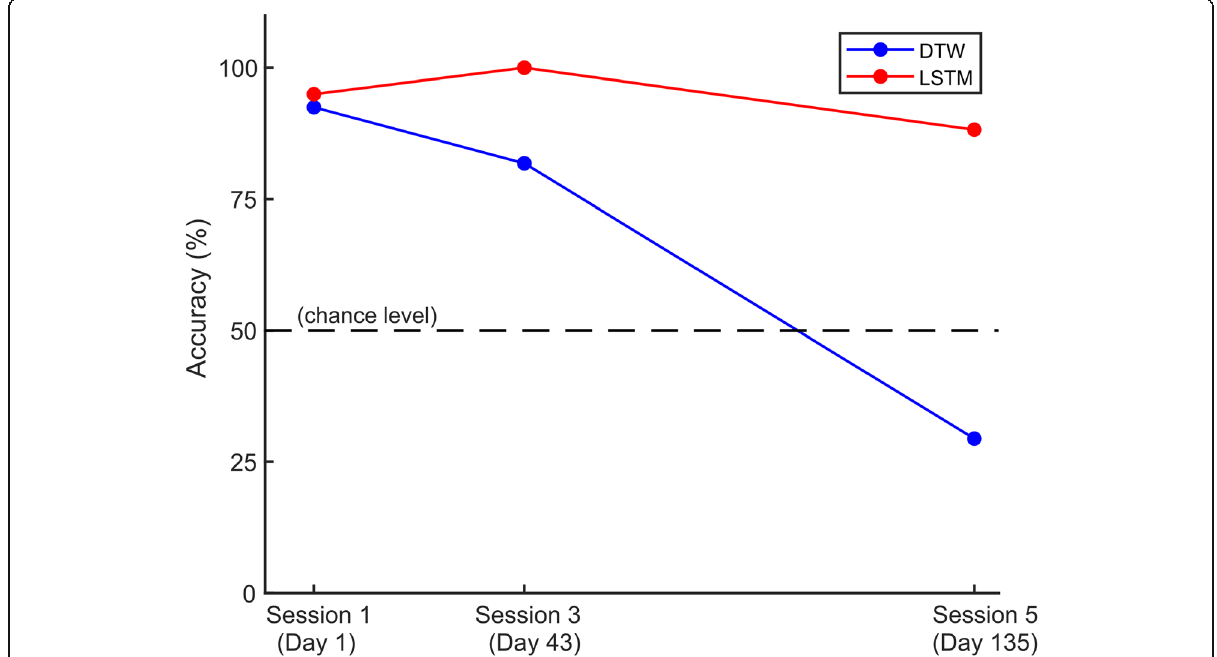
Fig. 4 Comparison of LSTM vs. DTW performance across multiple sessions. In this example, data recorded for two 2D trajectories S and Ɛ over three sessions were used for